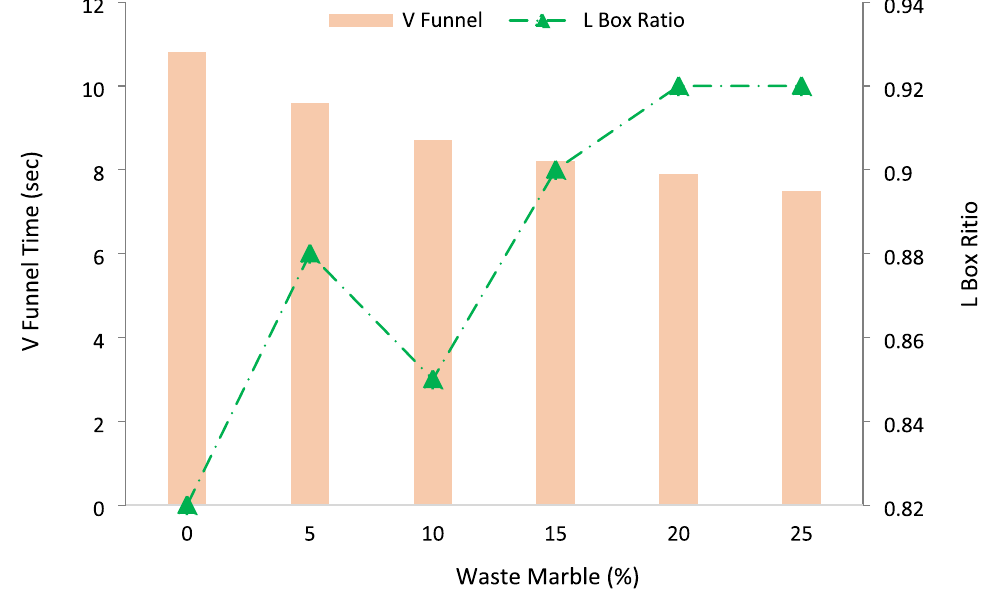
Fig. 6 V Funnel and L box ratio (Pala et al.,